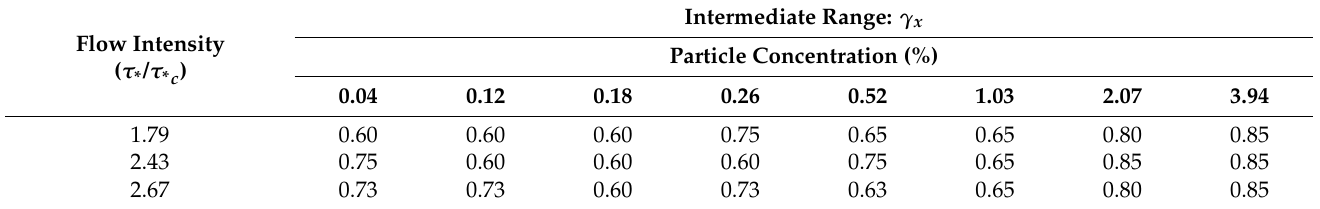
Table 5. Summary of values for γ x for particle diffusion in the intermediate range in the X-axis.